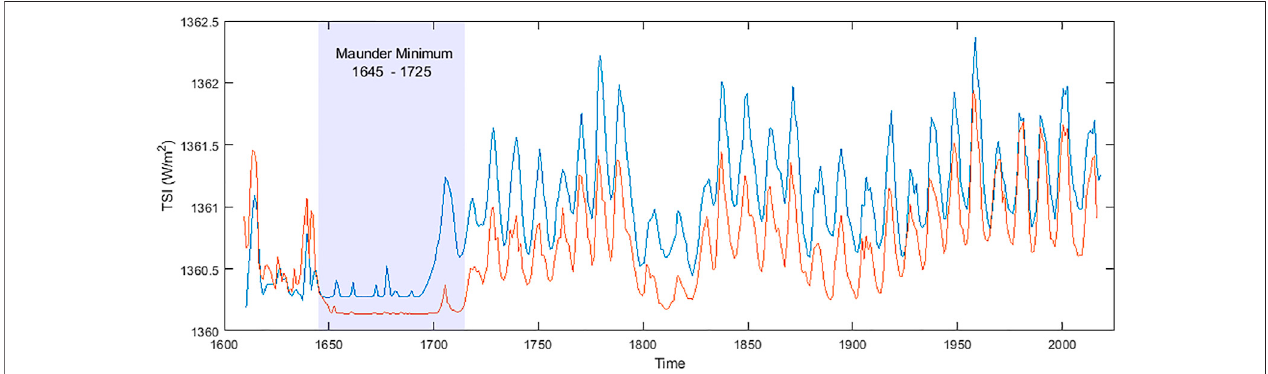
FIGURE 2 | Historical TSI reconstruction from 1610 to 2021. The comparison between Lean, J. L [54] 5 reconstruction (red line) and Koop, G reconstruction (blue line) 6 . The blue box highlights the Maunder minimum period from 1645 to